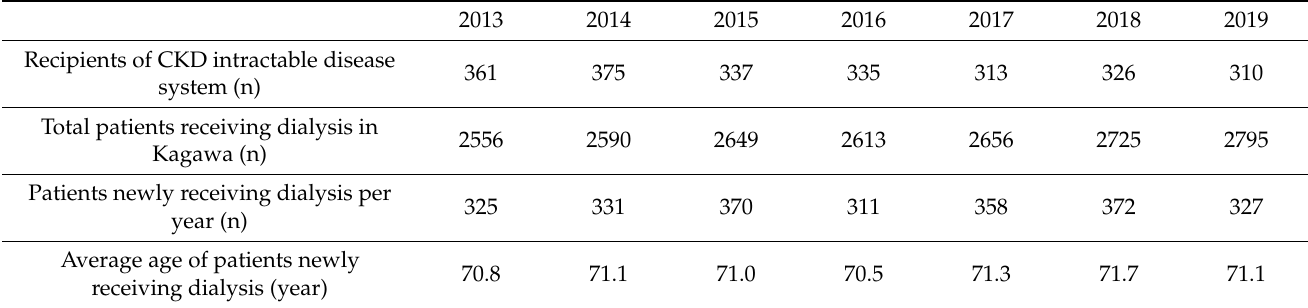
Table 2. Changes in the factors related to NHI health checkups and medical